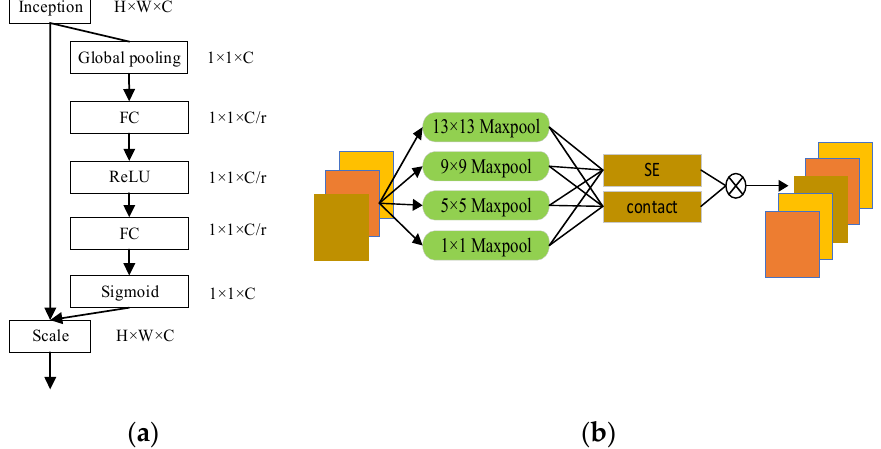
Figure 5. Improved pyramid structure. ( a ) SE spatial-attention-mechanism structure diagram, ( b ) improved SPPnet space diagram. ( b ) improved SPPnet space